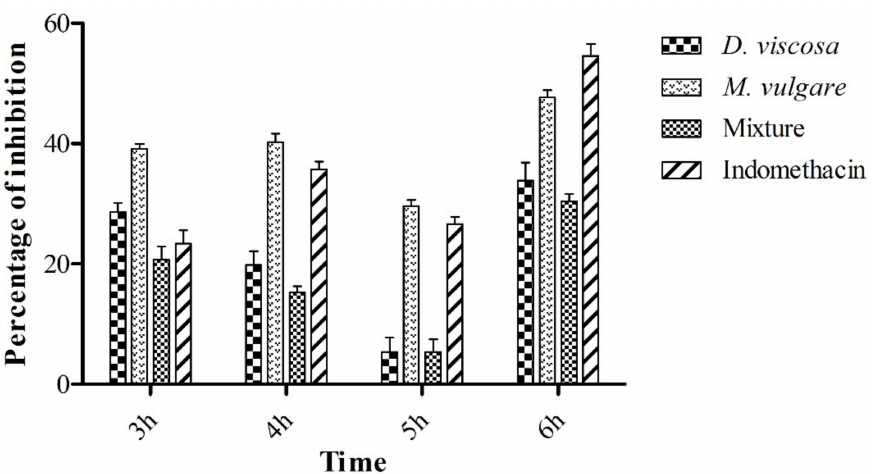
Figure 4. Effect of different hydro-ethanolic extracts administered orally on carrageenan-induced edema in rats. The percentage of inhibition concerning the circumference in the right paw of rats. The data represent the mean ± SD.